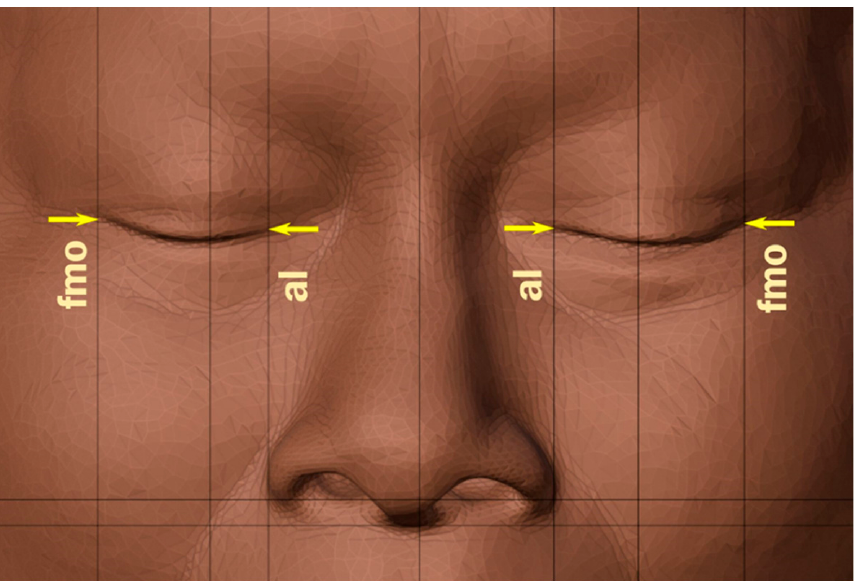
Figure 4. The fmo–fmo and al–al lines show compatibility with the eyelid extremities in a series of studies. However, the projection was inferior to that based on 30% of the fmo–fmo distance.